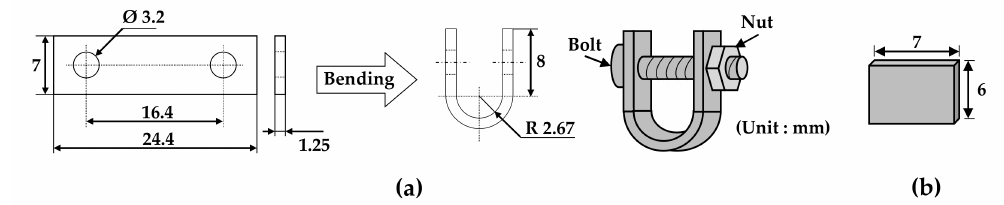
Figure 1. Dimensions of ( a ) a U-bend specimen and ( b ) a flat specimen for the immersion corrosion